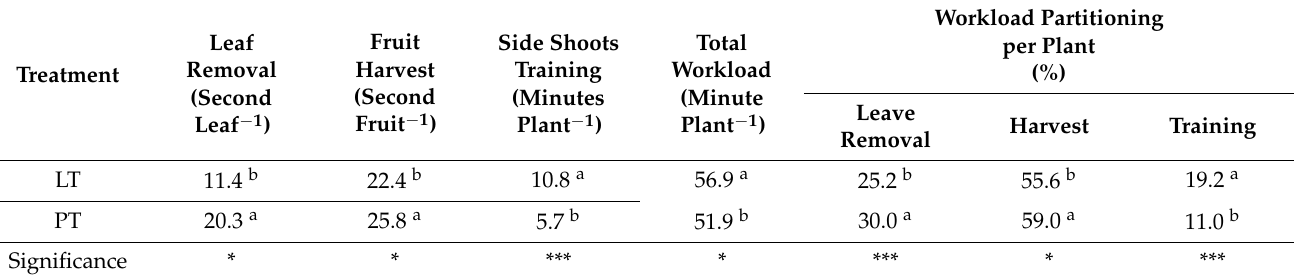
Table 8. Workload and workload